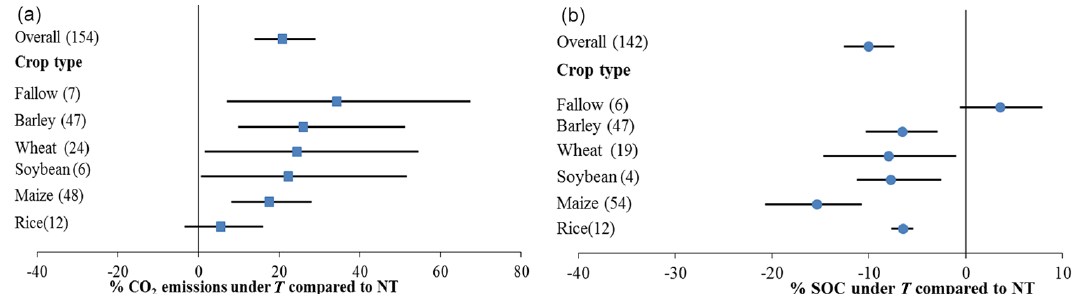
Figure 4. Percent change in (a) soil CO 2 emissions and (b) SOC in tillage ( T ) soil compared to no-tillage (NT) as a function of crop type. The numbers in the parentheses indicate the direct comparisons of meta-analysis. Error bars are 95% confidence